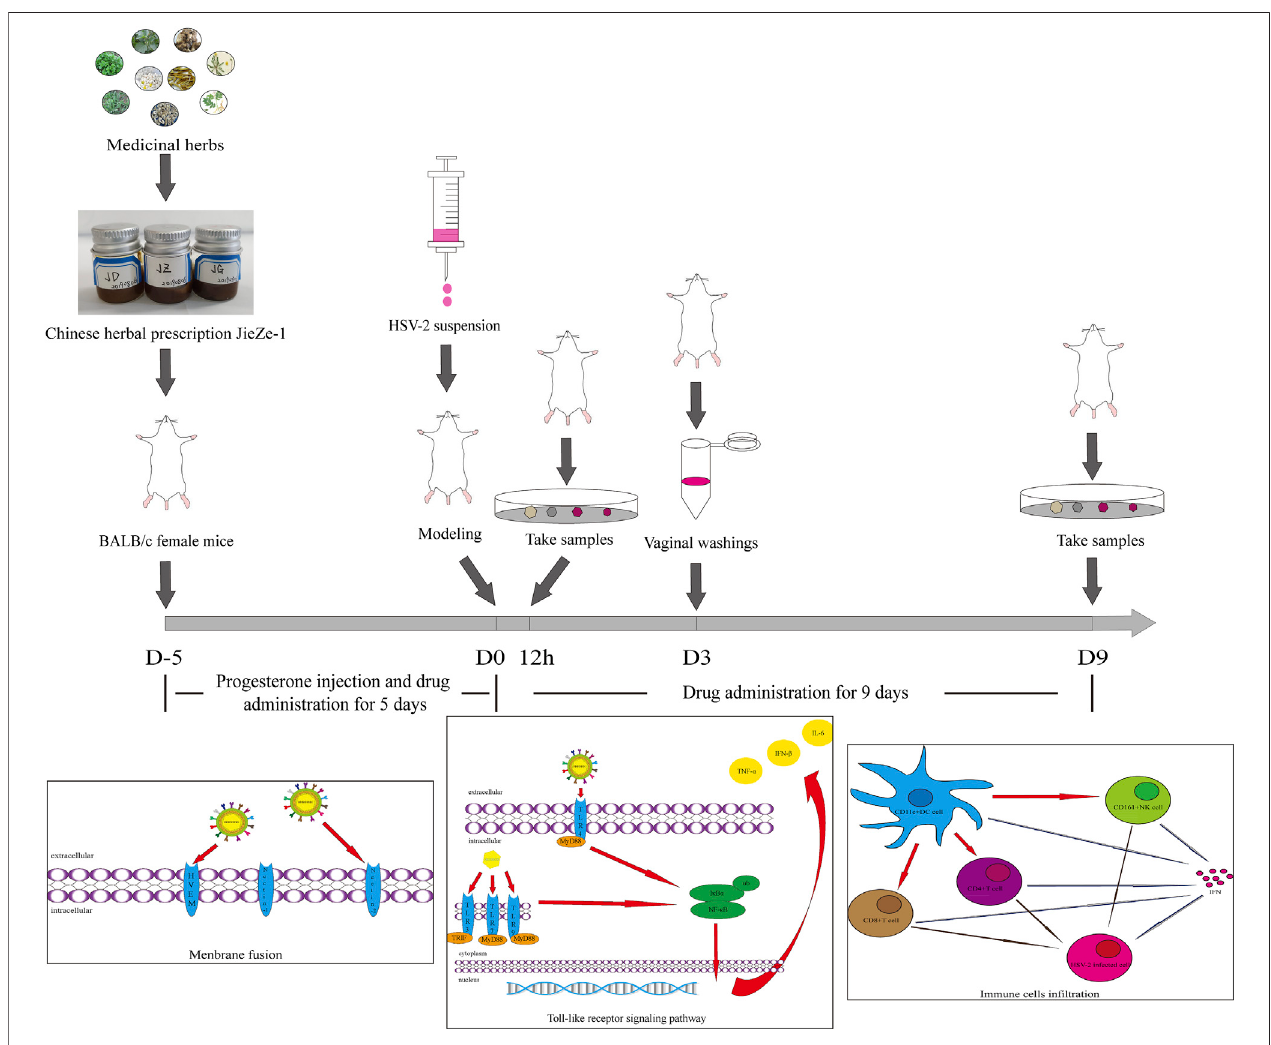
FIGURE 1 | The graphic illustration of the